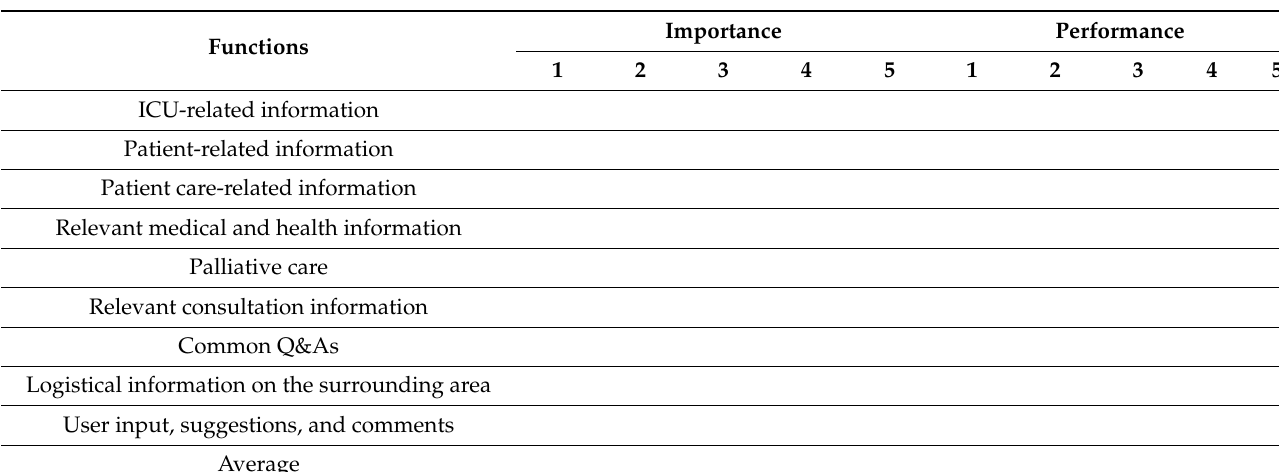
Table A3. Instrument of IPA.